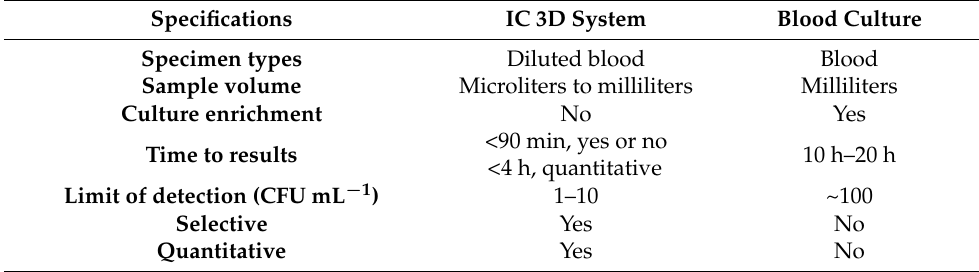
Figure 5. Schematic description of the IC 3D technology. This figure is a reproduction from reference [58], licensed under CC BY 4.0. ( a ) DNAzyme and blood samples are mixed and then encapsulated in microdroplets. DNAzyme sensors produce a fluorescent signal in the droplets with bacteria. ( b ) The 3D particle counter scans several milliliters worth of droplets within minutes and detects precisely single-fluorescent droplets. Table 2. Major specifications of the IC 3D test in comparison with blood culture for bacteria detection. Compilation adapted from [58], licensed under CC BY 4.0.